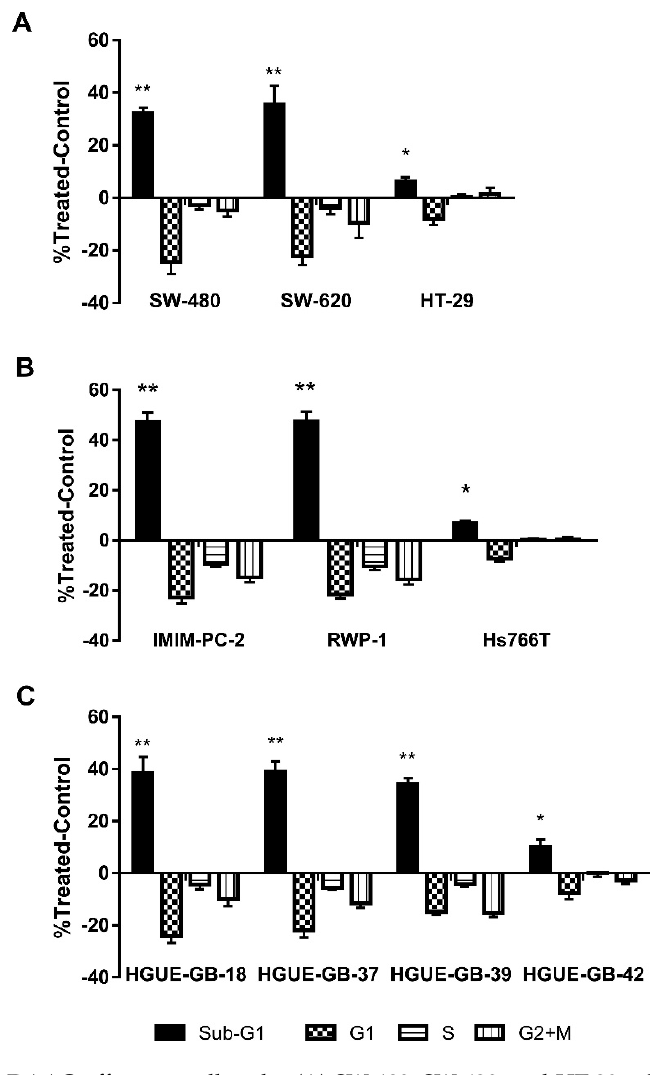
Figure 2. CLytA-DAAO e ff ects on cell cycle. ( A ) SW-480, SW-620, and HT-29 colon carcinoma cell lines, ( B ) IMIM-PC-2, RWP-1, and Hs766T pancreatic adenocarcinoma cell lines, and ( C ) HGUE-GB-18, HGUE-GB-37, HGUE-GB-39, and HGUE-GB-42 glioblastoma cell lines were treated with 2 U mL − 1 CLytA-DAAO and 1 mM D-Ala for 24 h and cell cycle distribution was determined by flow cytometry. Data represent the mean ± SEM of changes in the percentage of cells in each phase of the cell cycle compared with the untreated control, with n ≥ 6. * indicates p < 0.05 and ** p < 0.01. To determine the specificity of CLytA-DAAO treatment for tumoral cells, we determined CLytA-DAAO toxicity on non-tumor cell lines. We tested the CLytA-DAAO e ff ect on lymphocytes primary cultures from non-oncological patients at HGUE, in mouse 3T3-L1 adipocytes, and in human non-tumoral cell lines from fibroblast (IMR90, 1BR3.G) and pancreas (HPDE). Results in Figure 3 show that CLytA-DAAO treatment only induced a minimal cell death in the IMR90 cells.